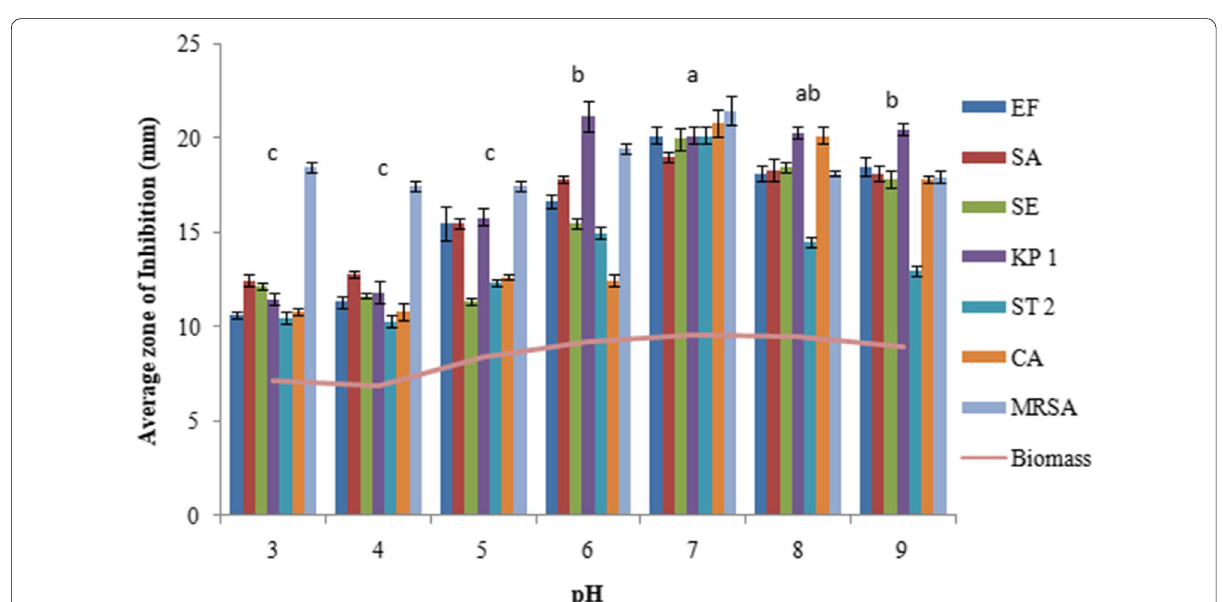
Fig. 5 Effect of pH on antimicrobial activity of C. globosum . EF, Enterococcus faecalis; SA, Staphylococcus aureus ; SE, Staphylococcus epidermidis ; KP1, Klebsiella pneumoniae 1; ST2, Salmonella typhimurium 2; CA, Candida albicans MRSA, Methicillin-resistant Staphylococcus aureus . *Values are given as mean SE. Different letters (a to c) between the columns are significantly different (post hoc tukey Test, p ±